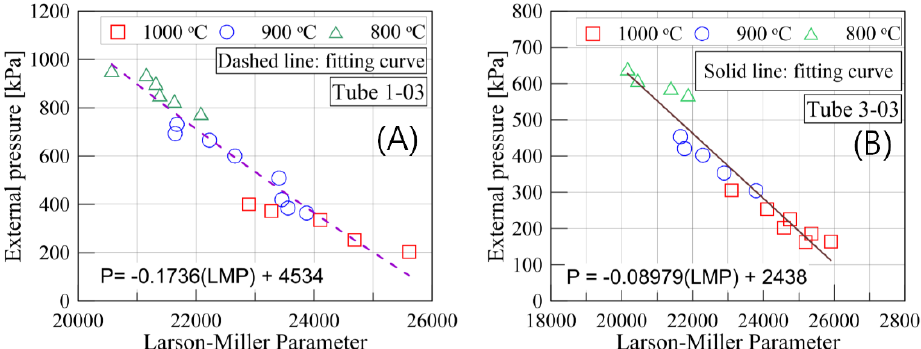
Figure 11. LMP variations with respect to the external pressure for ( A ) Tube 1-03 and ( B ) Tube 3-03.